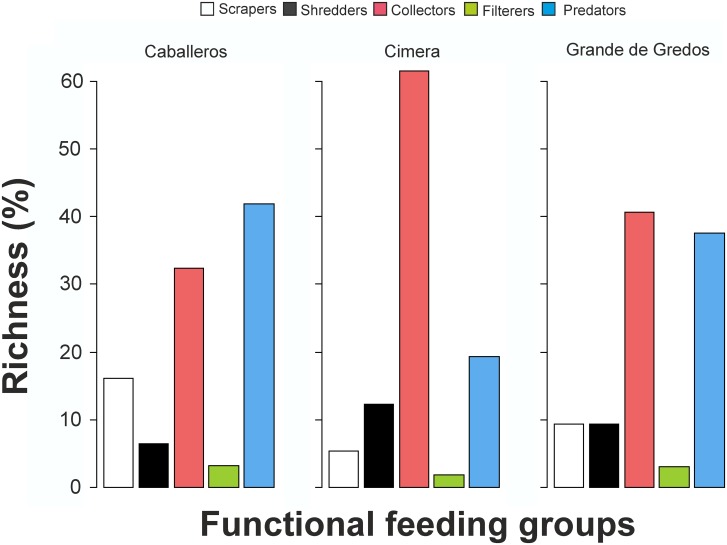
Functional feeding groups.Functional feeding groups of the macroinvertebrate community in each lake.